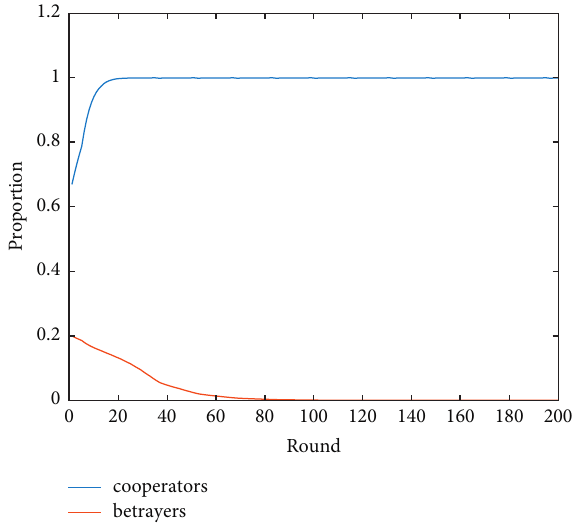
Figure 1: The evolution of population with honest and malicious